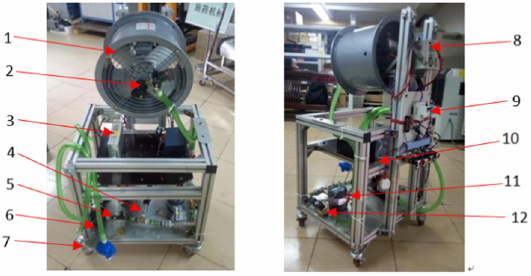
Figure 5. Structure of the spraying test platform: (1) airflow fan, (2) nozzle, (3) power switch, (4) puma, (5) filter, (6) adjustable relief valve, (7) manometer, (8) frequency converter, (9) fan switch, (10) intelligence flow totalizer, (11) flowmeter, and (12) solenoid valve.